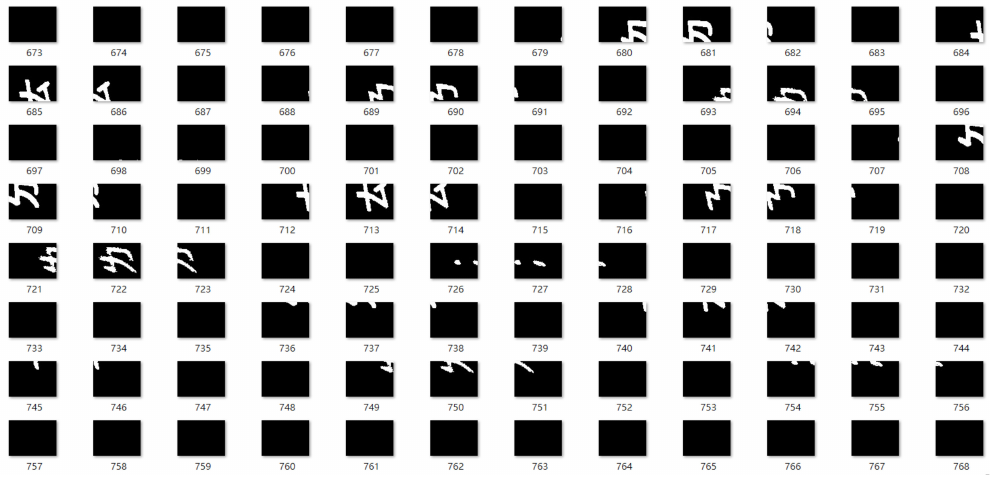
Figure 3. Procedure of image recognition technique.